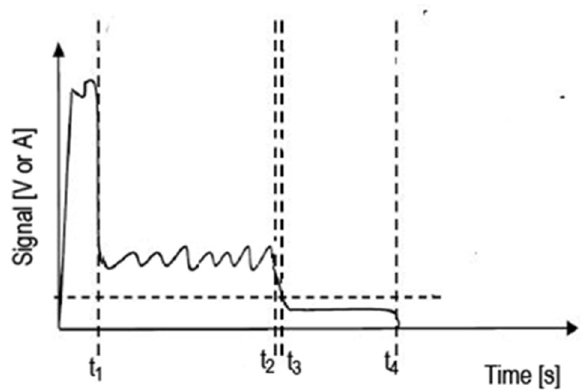
Figure 3. Typical signal recorded by photodiodes during the piercing process.